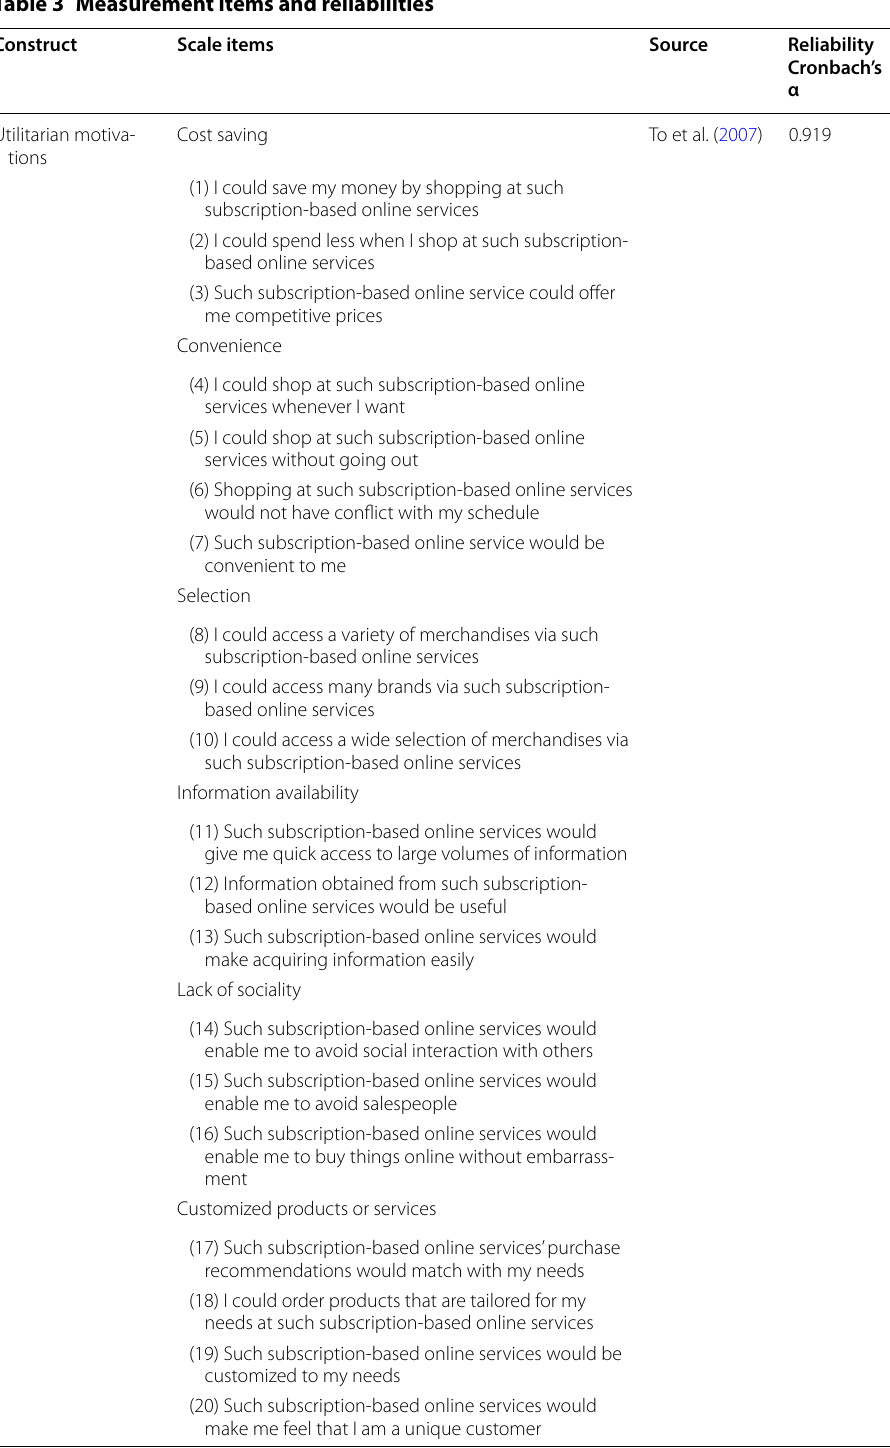
Table 3 Measurement items and